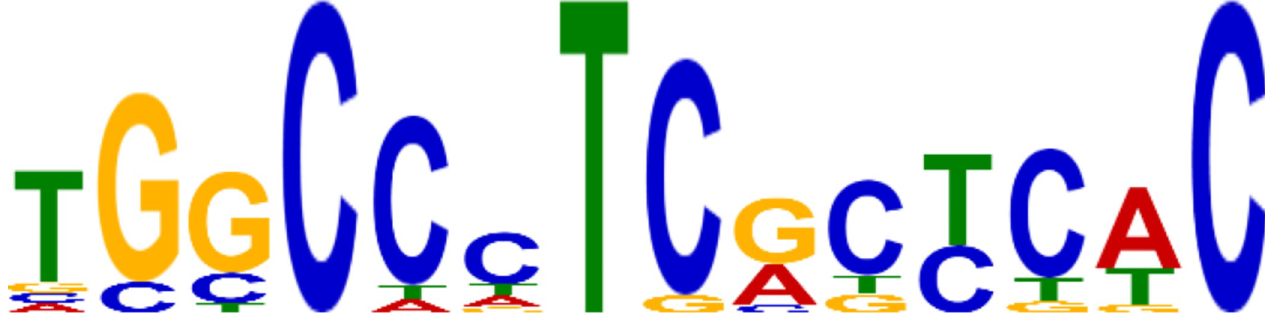
Fig 7. Over-represented promoter sequences. Results of MEME output showing consensus sequence. The size of the font for a given nucleotide is indicative of its representation in the consensus sequence among the 95 genes down-regulated in Joelle after cold acclimation.